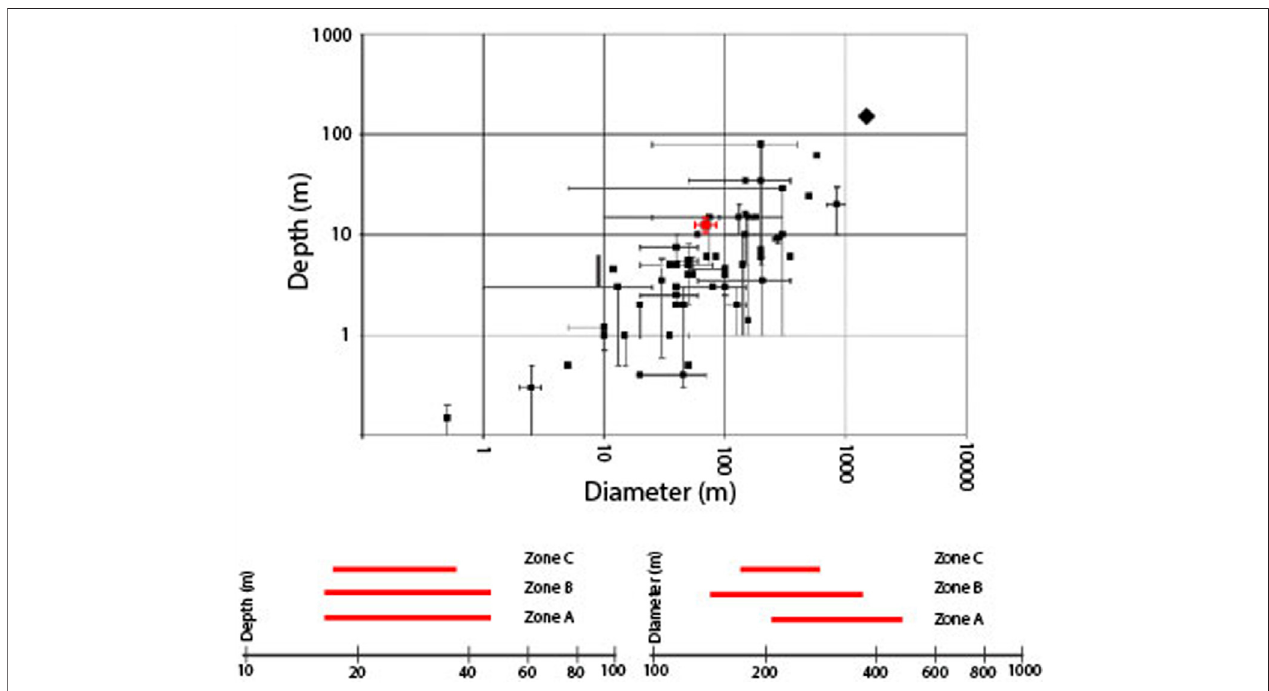
FIGURE 13 | Graph illustrates the pockmark geometry of previously studied pockmarks from 57 published sites, complied by Pilcher and Argent (2007) in comparison with this study at the GSB. The X and Y scales are logarithmic. The paleo-pockmark geometry of this study is presented by a red cross-hair by applying a velocityof 2.0 km/s. Pilcher and Argent (2007) used single points to represent either measurementsof single pockmarksor average measurementsand used error bars to represent the range of sizes in a pockmark fi eld.